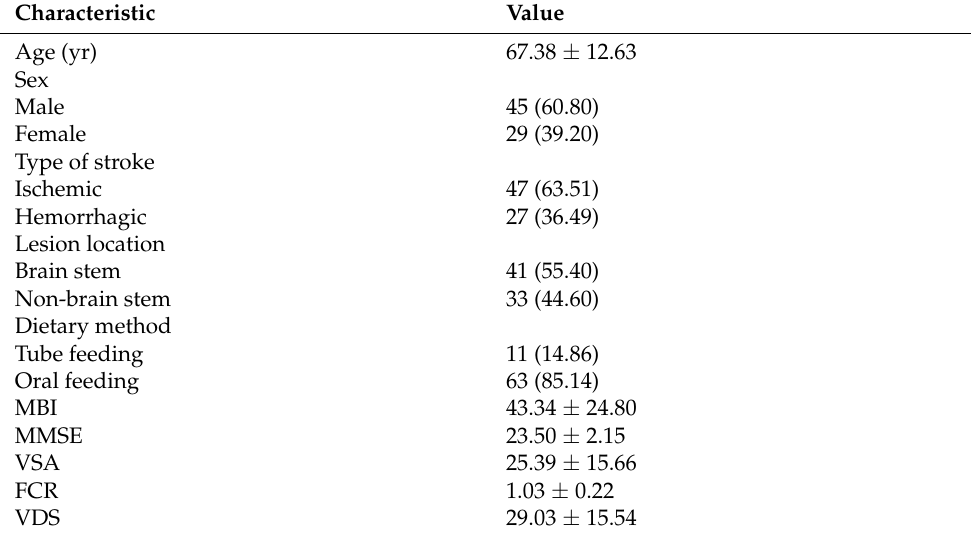
Table 1. Demographic and clinical data of patients.